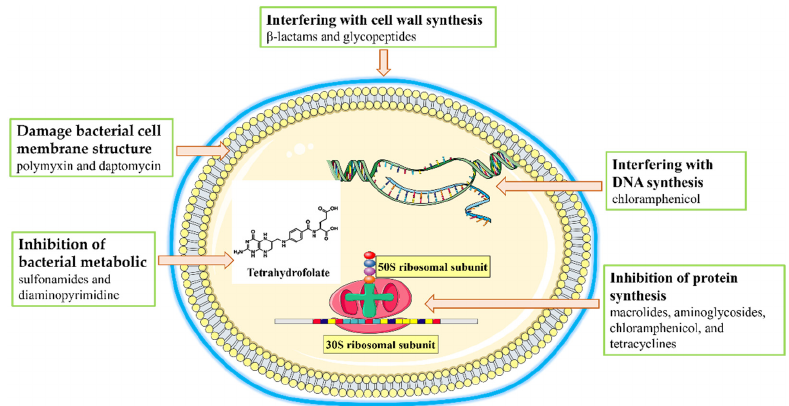
Figure 3. Antimicrobial mechanisms of antibiotics.